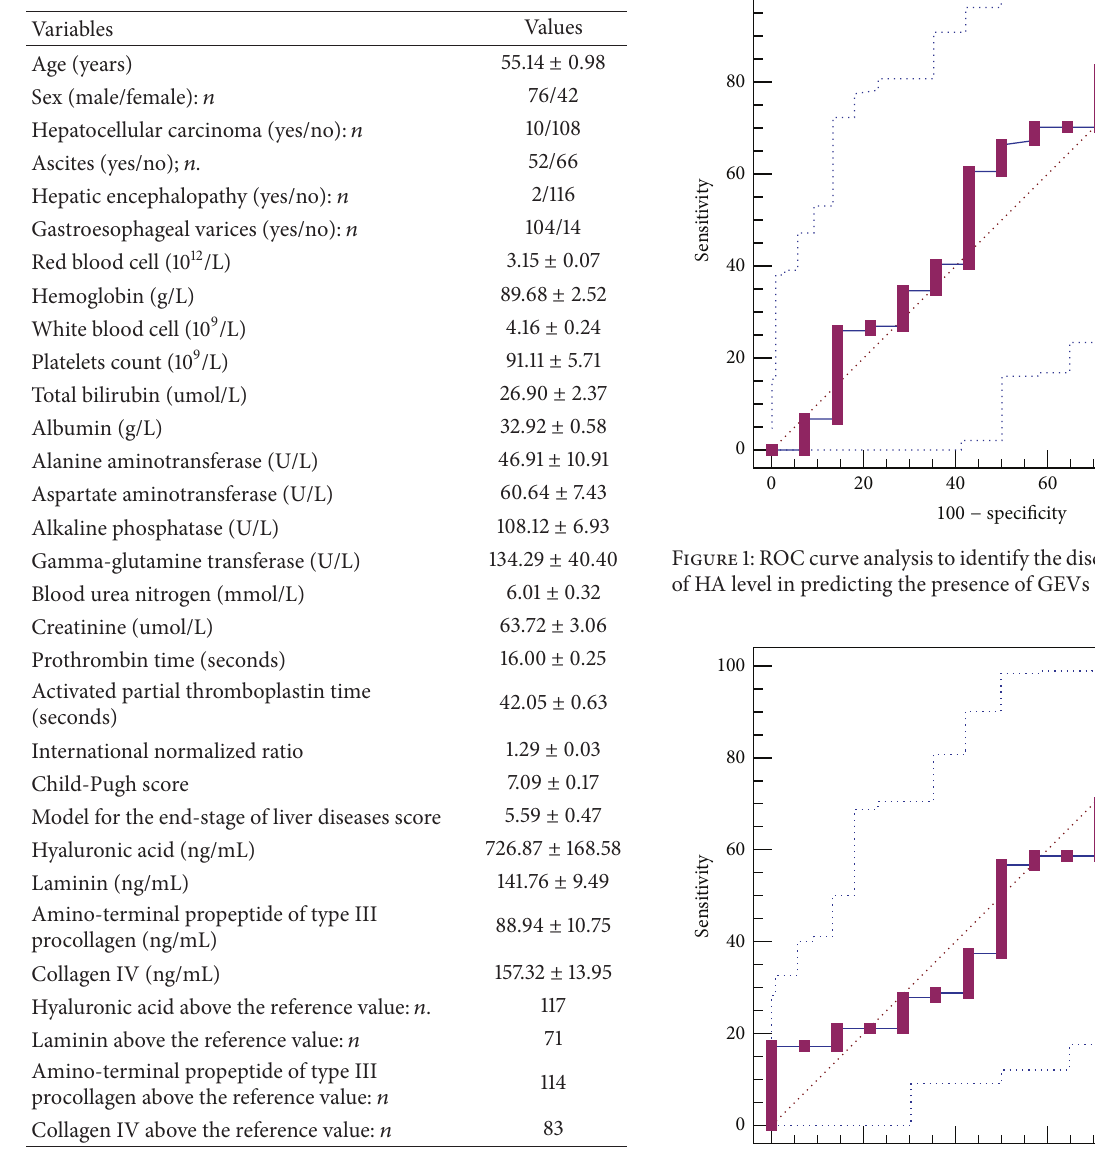
Table 1: Characteristics of patients.